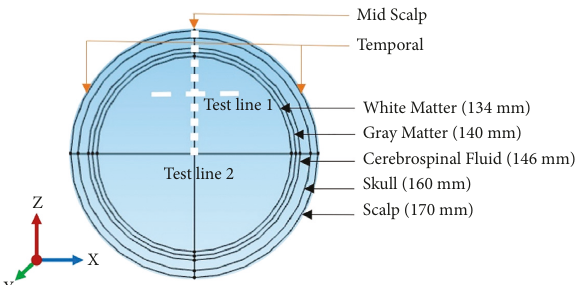
Figure 1: The cross-sectional view of five layers of the spherical human head